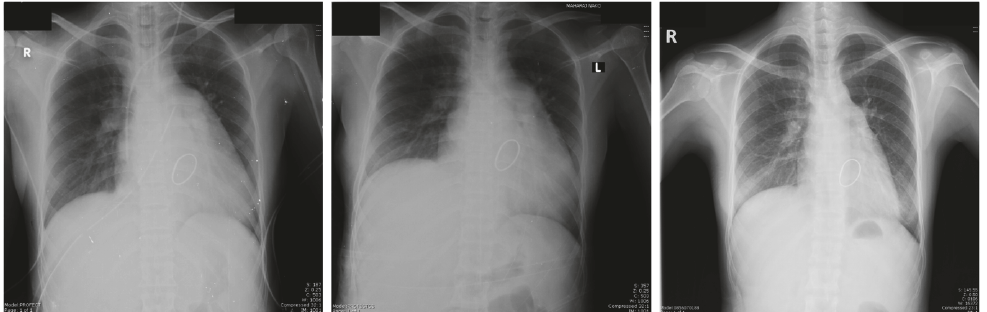
Figure 3: Serial of postoperative chest X-rays showed gradual reduction in cardiac